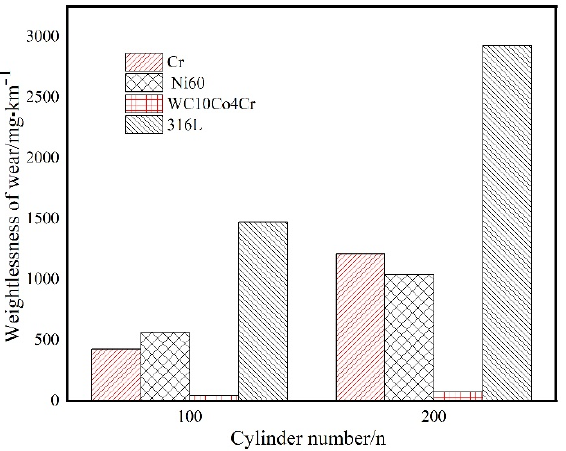
Figure 10. The wear rate of hard chrome plating and HVOF